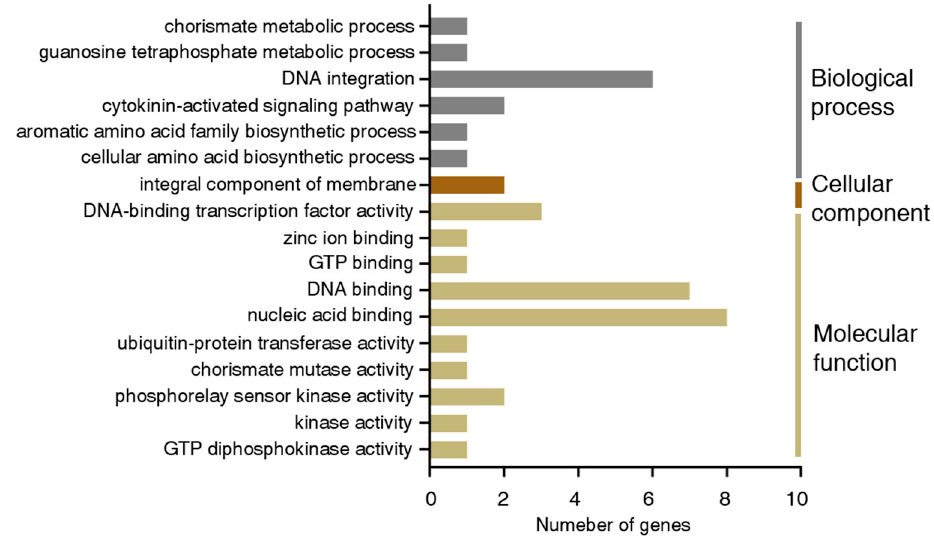
Figure 5. GO enrichment of predicted miR159-targeted genes in D. officinale . All predicted Dof- miR159-targeted genes were classified into 3 categories distinguished by different colors.